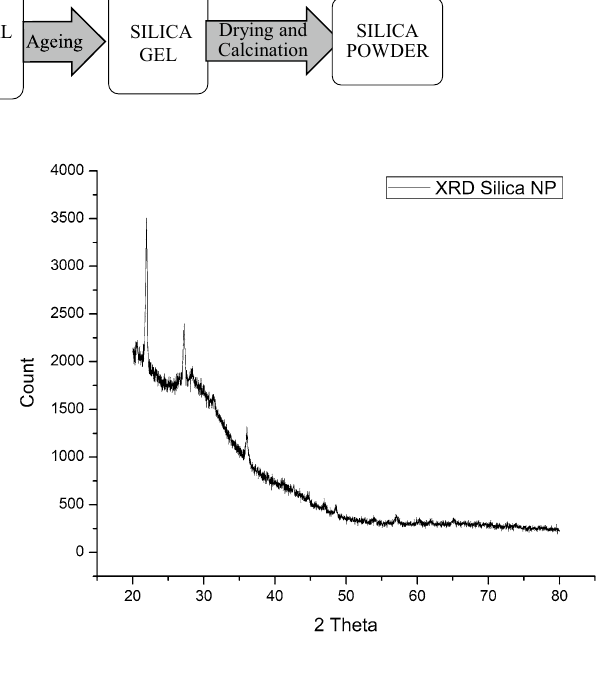
Fig. 1 XRD of silica NP after calcination